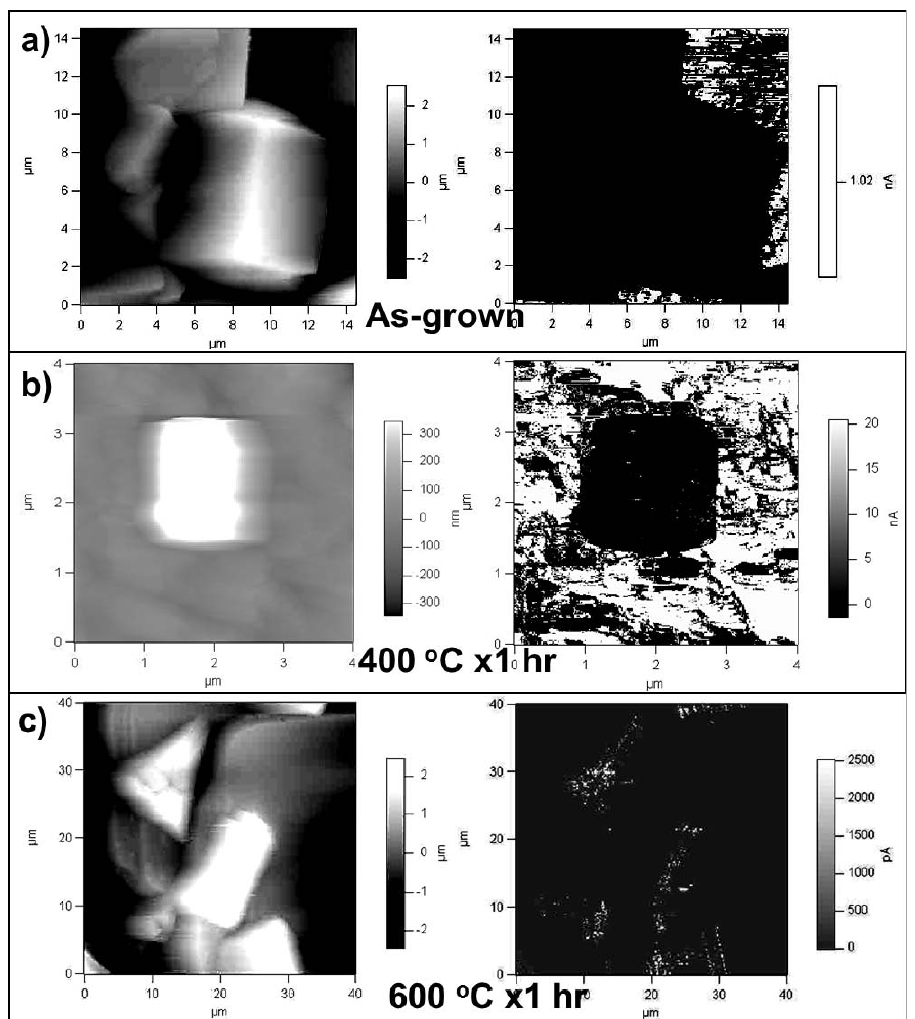
Figure 18. Initial atomic force microscopy micrographs obtained on ZHS cube surfaces after thermal annealing at different temperatures: ( left ) topography image; ( right ) conductivity map corresponding to the topography